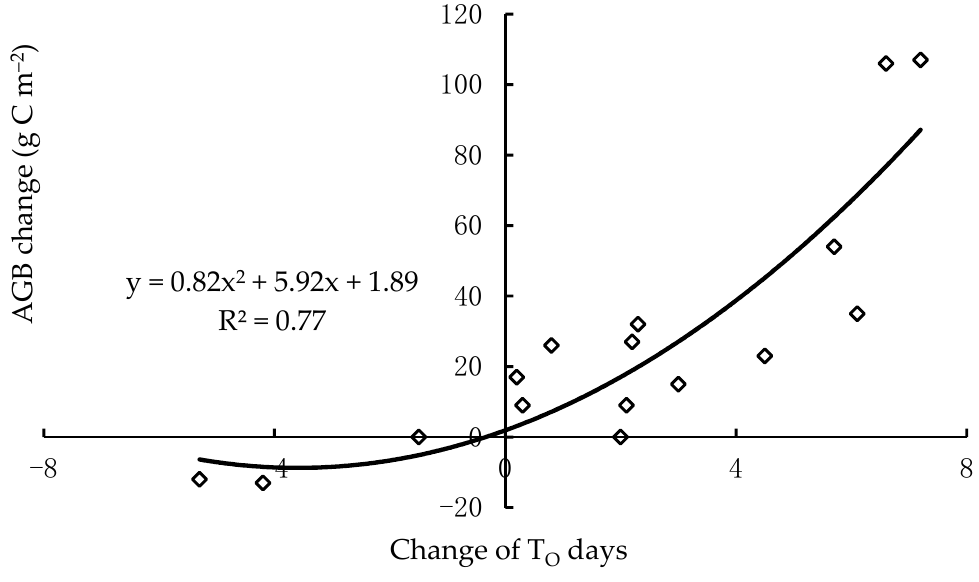
Figure 4. Relationship between the change in T O days and aboveground biomass (AGB). 227